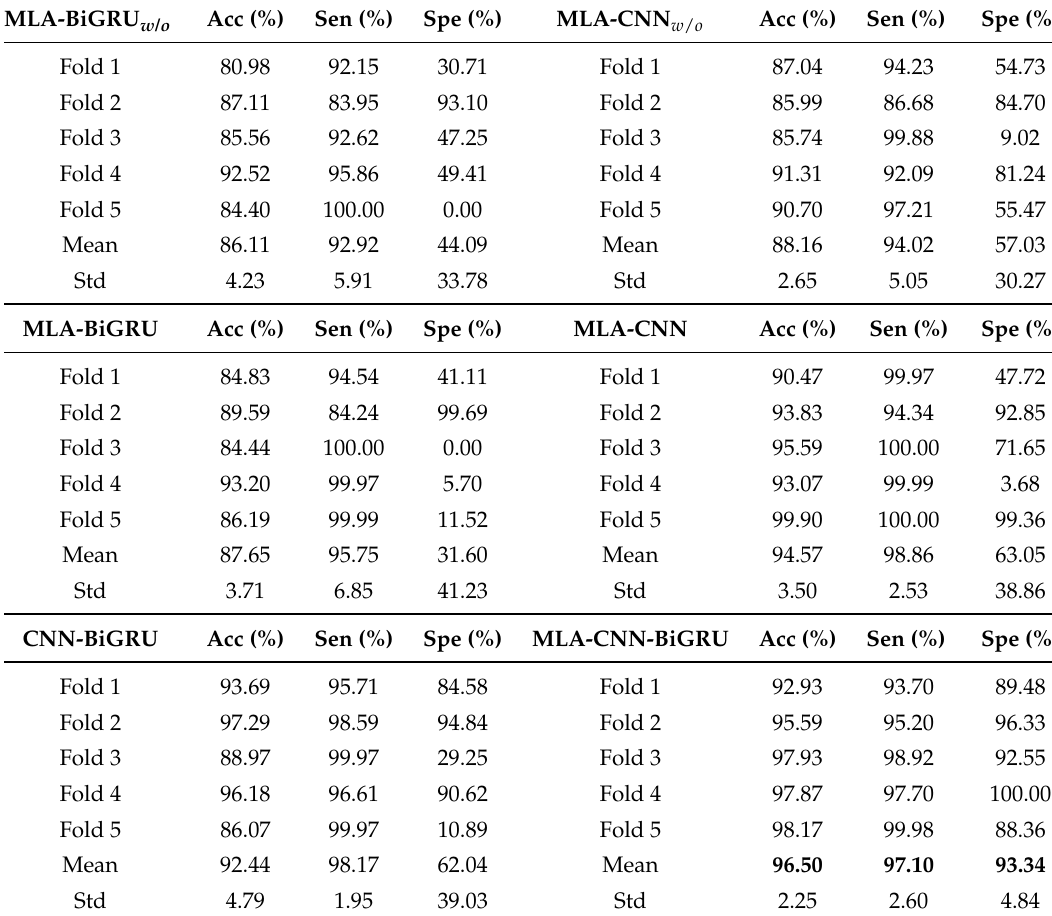
Table 4. Ablation experiments of MI detection by five-fold cross-validation under inter-patient scheme. MLA-BiGRU w /